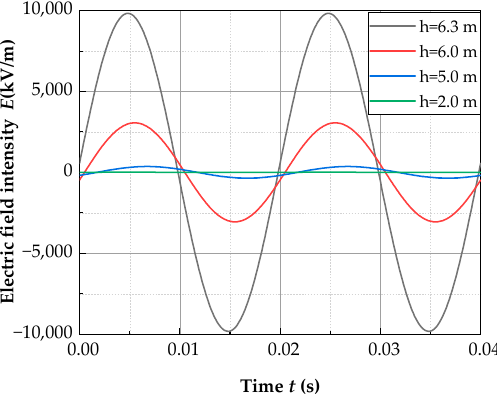
Figure 4. The electric-field variation curves of the integration nodes at different positions below the A-phase conductor of the 10 kV line.